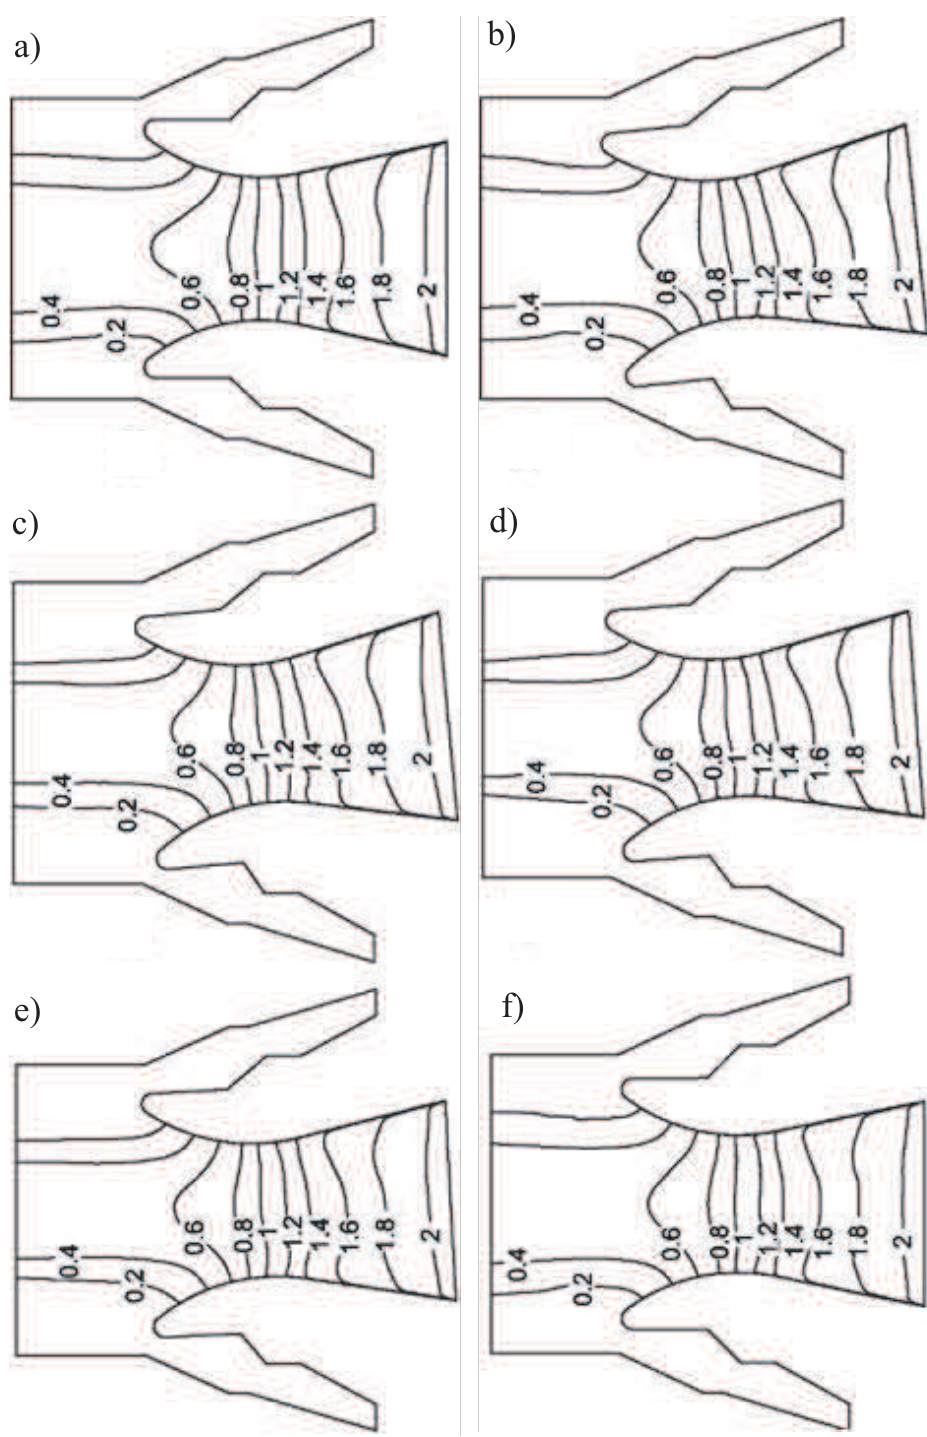
Figure 15. Contours of Mach number in nozzle for various planes for angle of nozzle rotation 6 ◦ ( a – f